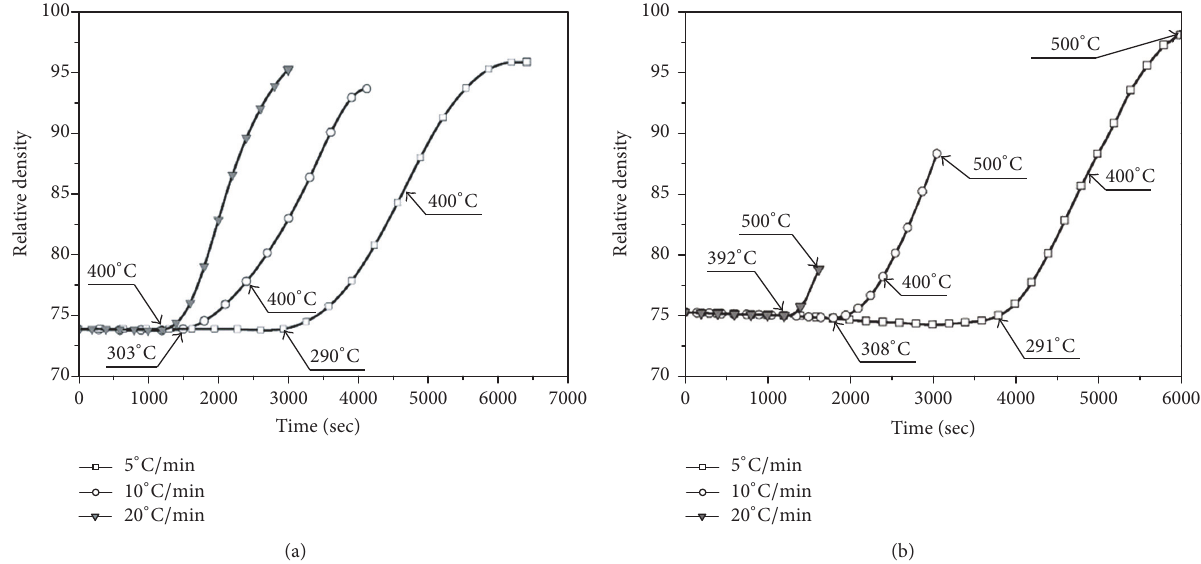
Figure 3: Densification curves: (a) sintering temperature of 400 ∘ C, pressure of 50 MPa, and holding time of 30 min; (b) sintering temperature of 500 ∘ C, pressure of 50 MPa, and no holding time.